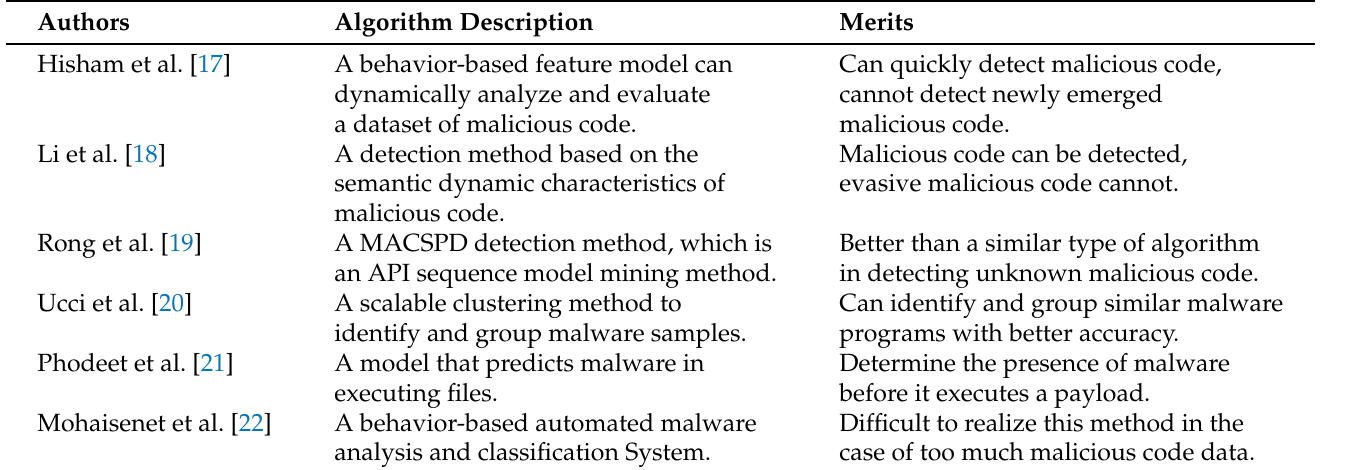
Table 2. The dynamic detection methods.